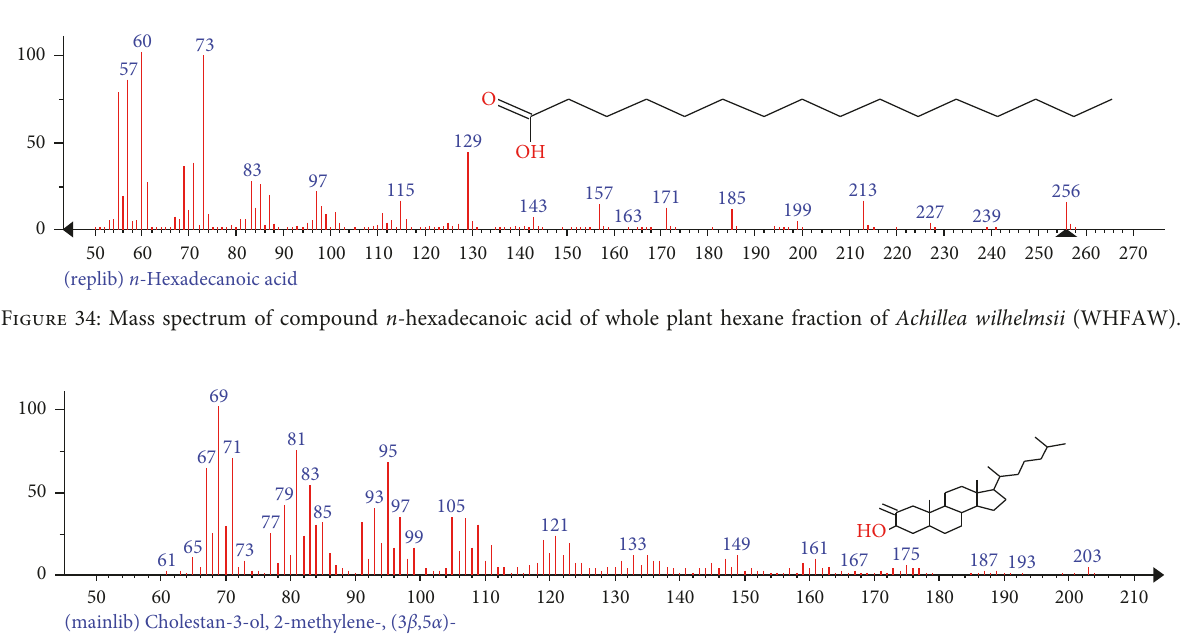
Figure 35: Mass spectrum of compound cholestan-3-ol, 2-methylene-, (3 β ,5 α )- of whole plant hexane fraction of Achillea wilhelmsii (WHFAW).